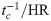
Evaluation of the second method of Weyand et al. using gender and tc-1/HR as features.